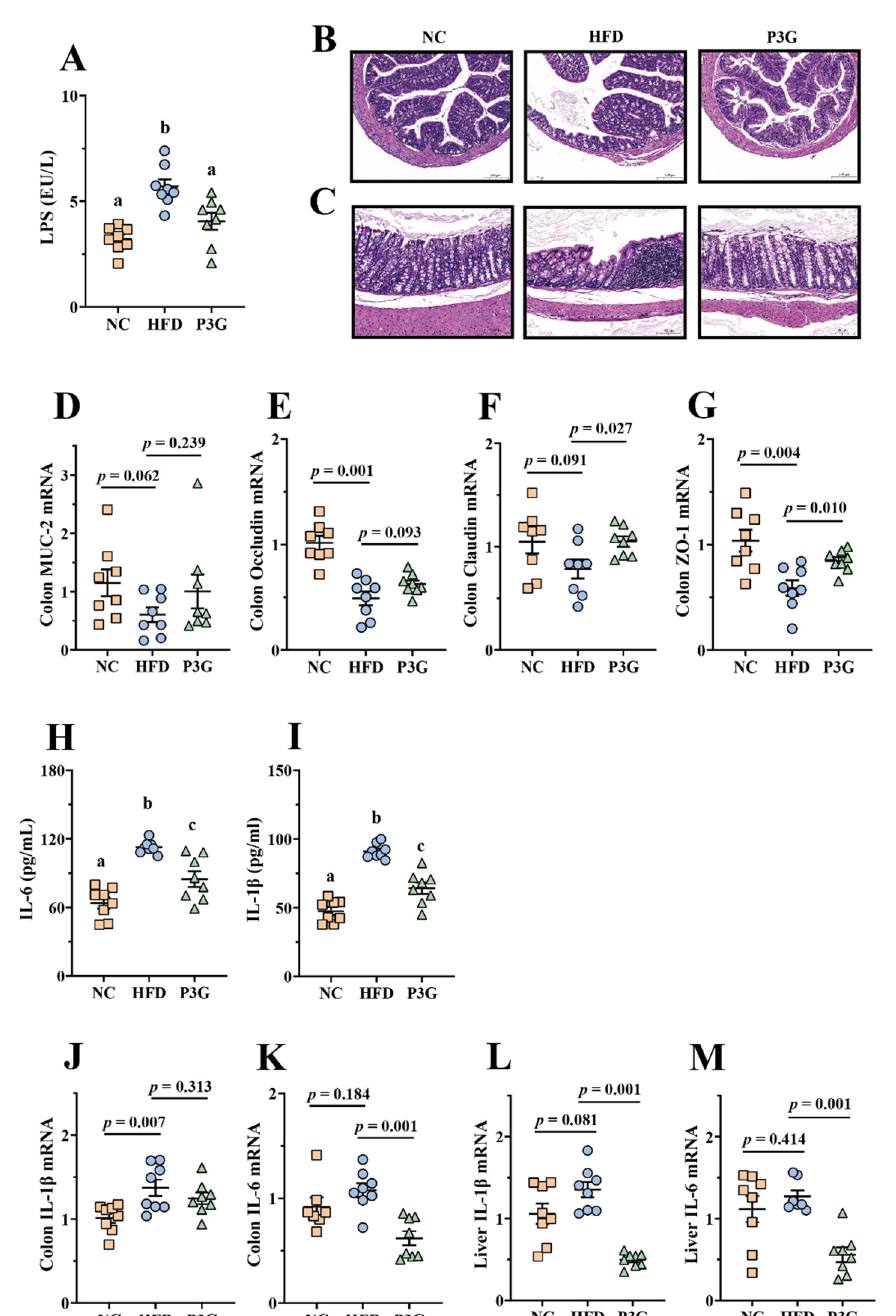
Figure 3. P3G relieved inflammation and improved the integrity of the intestinal barrier in HFD- induced mice: ( A ) LPS in plasma; ( B , C ) representative H&E pictures of colon (scale bars, 100 µ m); ( D – G ) MUC-2, Occludin, Claudin and ZO-1 mRNA levels in the colon; ( H , I ) IL-6 and IL-1 β in plasma; ( J , K ) IL-1 β and IL-6 mRNA levels in the colon; ( L , M ) IL-1 β and IL-6 mRNA levels in the liver. Data are expressed as mean ± standard error (mean ± SEM) and were analyzed using one-way analysis of variance (ANOVA); a, b, and c represent significant differences between groups. The same letter indicates no significance between the two groups, and different letters indicate significance ( p <